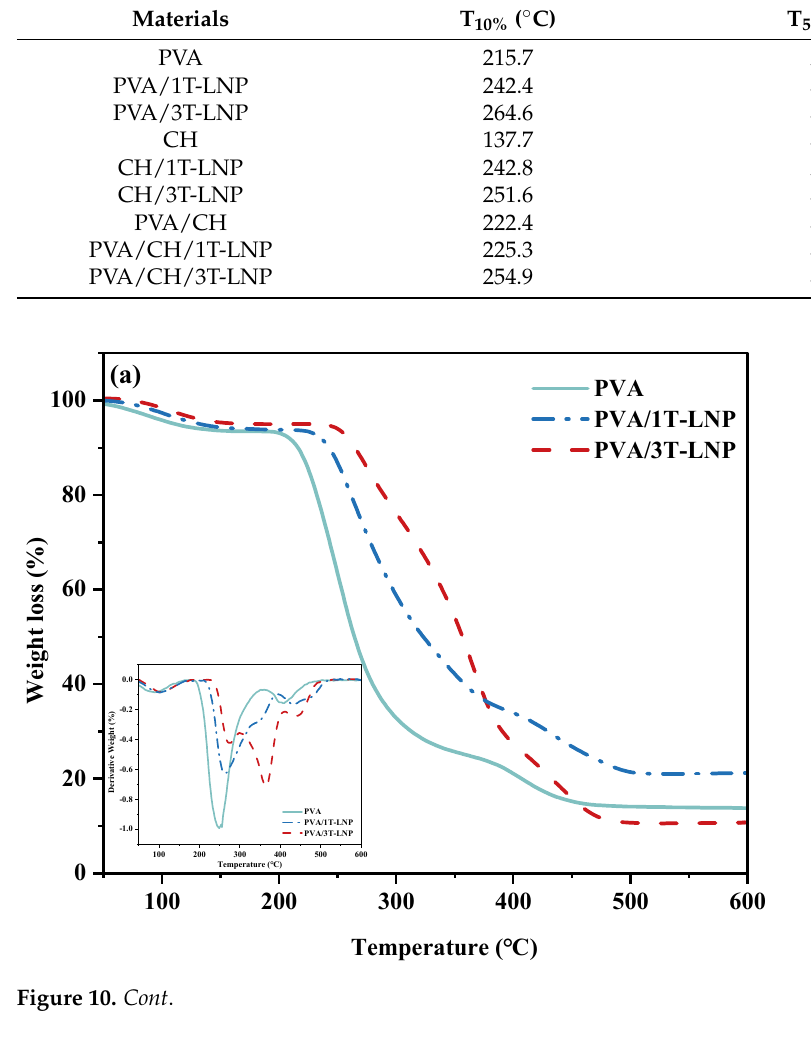
Table 6. Antioxidation activity of the migrating substances for PVA, CH and PVA/CH/T-LNP nano- composites.